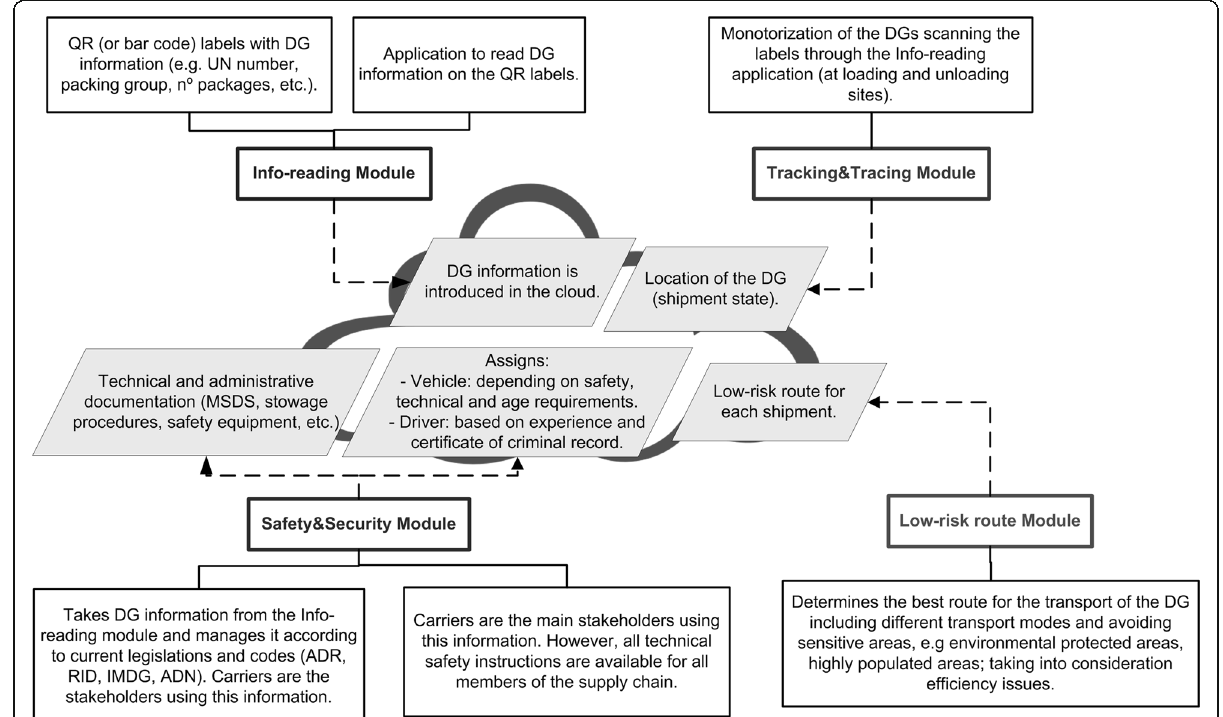
Fig. 3 Prototype scheme of the new cloud computing solution for the transport of dangerous